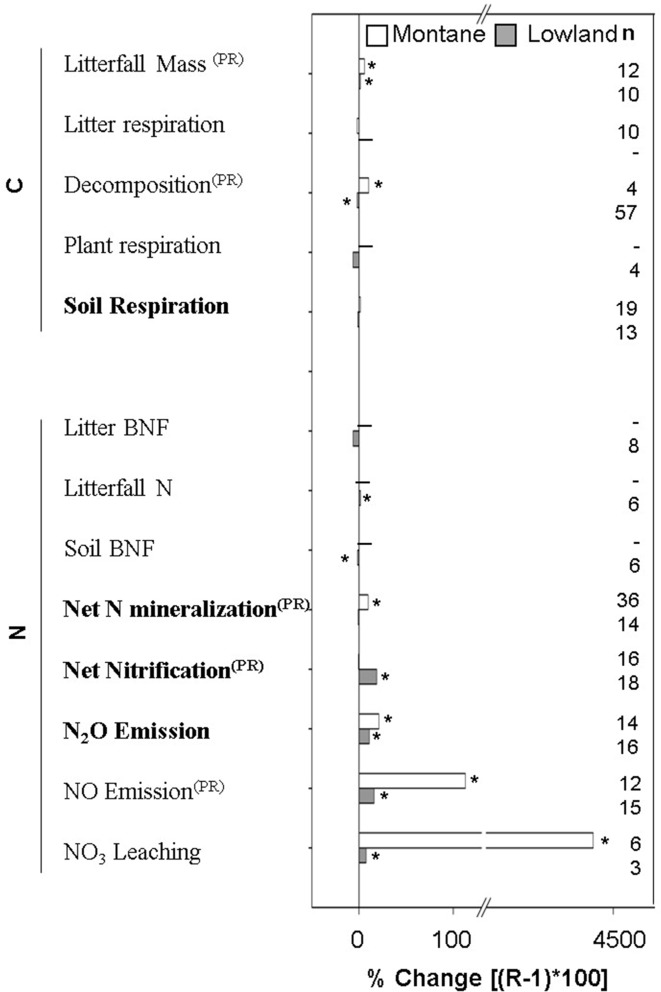
Percentage of change for flux variables.An asterisk (*) represents a significant percentage of change with the N addition. A PR superscript indicates significantly different change between montane and lowland forests (ProRand ≤ 0.05). Bolded variables represent significant associated total heterogeneity (Qt; p ≤ 0.05).